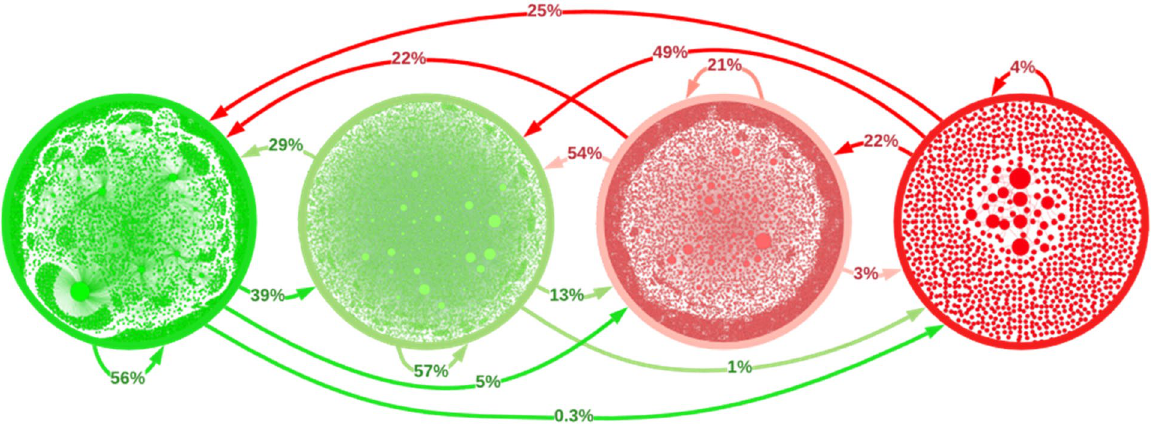
Figure 6. Subnetworks of only pro-vaccine (left), promoter (center-left), inhibitor (center-right), or anti- vaccine (right) nodes and their interaction flows. Each circle contains an image of the network that is